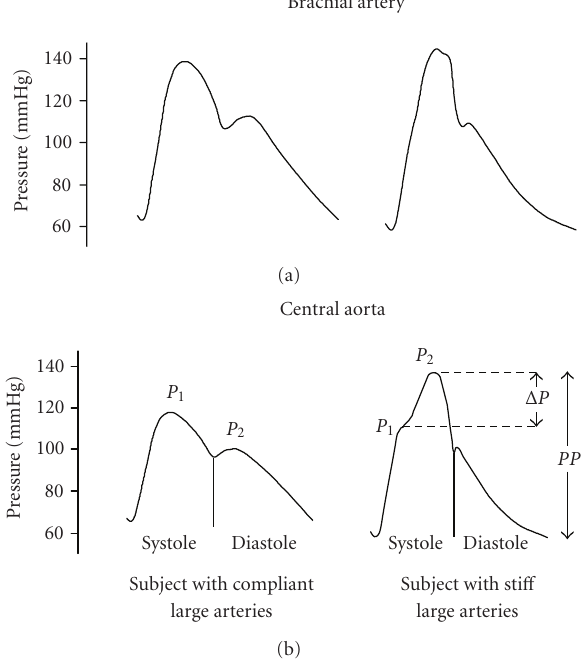
Figure 2: Schematic representation of pulse pressure amplification. Pressure tracings from the brachial artery and central aorta are shown, from a young individual with a highly compliant vasculature tree (left) and from an old one with sti ff vessels (right). Despite similar brachial blood pressures, central blood pressures vary con- siderably. In young individuals, P 1 (which coincides with systolic blood pressures) marks the outward traveling blood pressure wave, while P 2 represents the arrival of the reflected pressure wave in diastole, augmenting diastolic blood pressure, and coronary filling. Pulse pressure augmentation in old, sti ff vessels leads to a significant increase in P 2 as compared to P 1 , as wave reflection occurs earlier and faster, leading to an augmentation in systolic blood pressure. Augmentation index is calculated as the di ff erence between the second ( P 2 ) and first ( P 1 ) systolic peaks (delta P ) as a percentage of pulse pressure (see